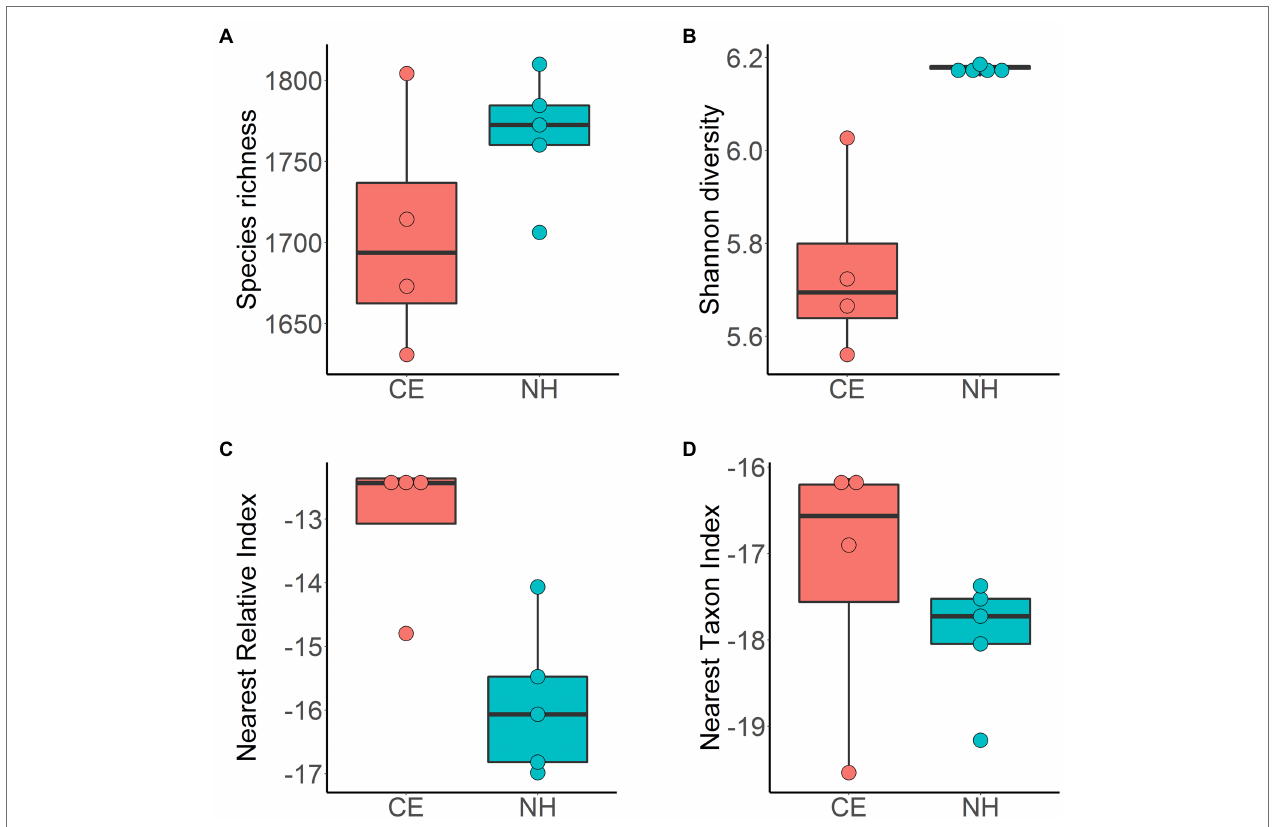
FIGURE 4 | Alpha diversity of microbial communities in surface sediment samples from Cape Evans (CE, red) and New Harbour (NH, blue) estimated using metrics of species richness (A) , Shannon–Wiener index (B) , the nearest relative index (C) , and the nearest taxon index (D) . Horizontal bar represents value of sample median, box represents the interquartile range, and whiskers represent maximum and minimum